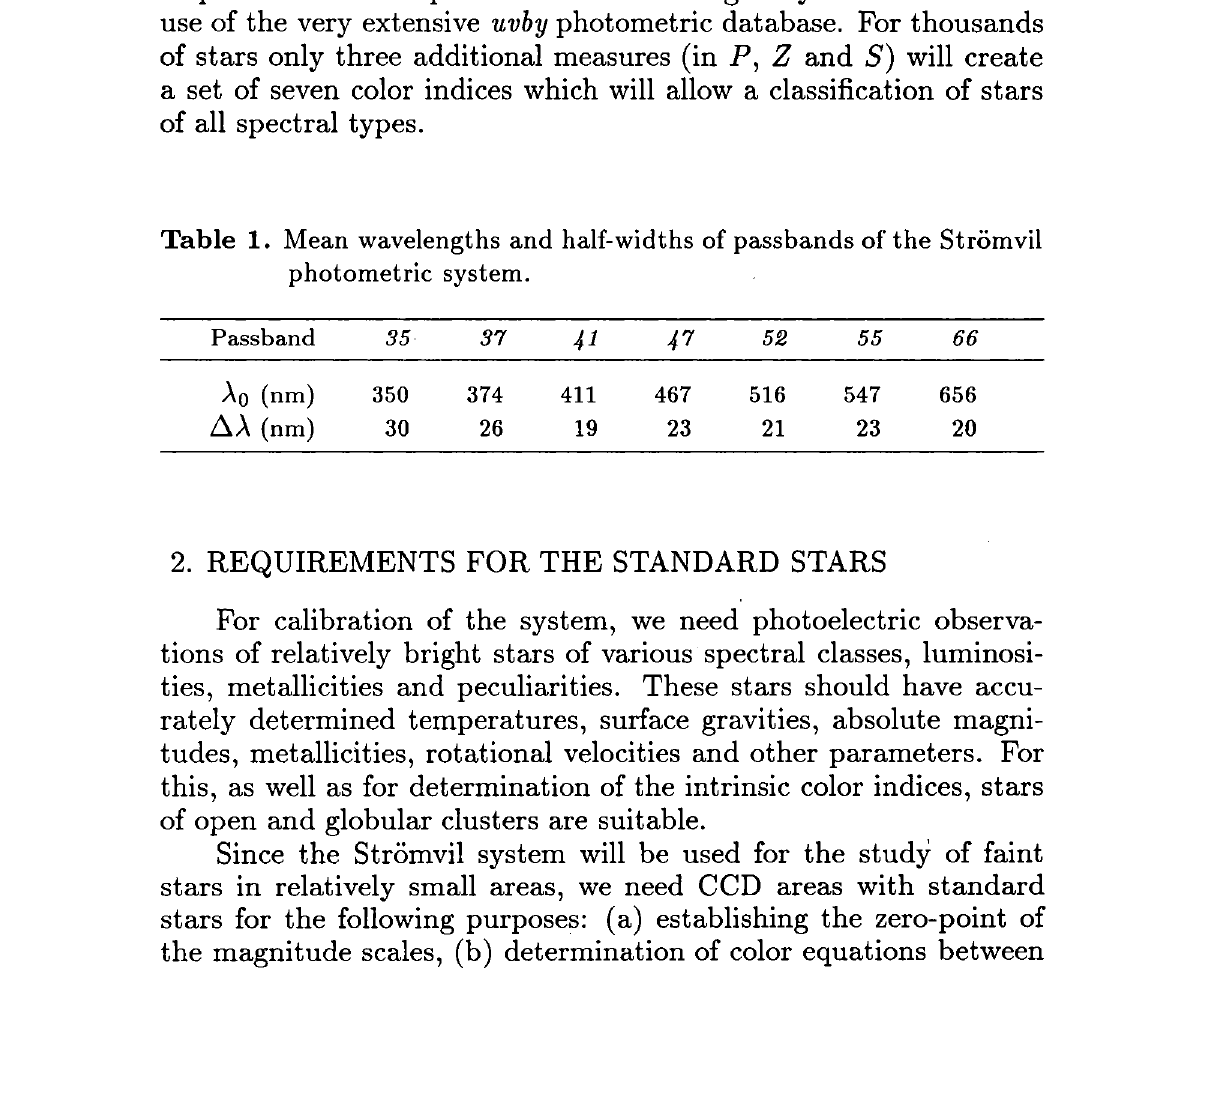
Table 1. Mean wavelengths and half-widths of passbands of the Strömvil photometric